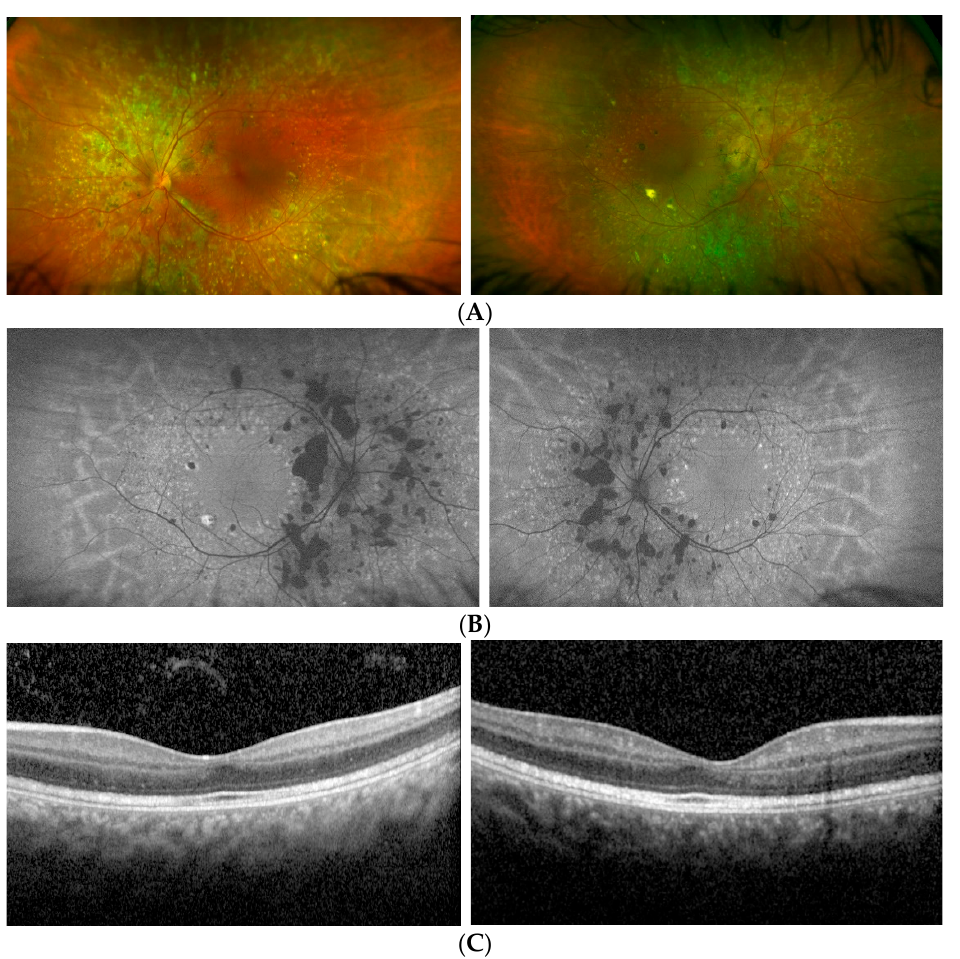
Figure 2. Retinal features of Patient 2: ( A ) Fundus of the right and left eye showing areas of chorioretinal atrophy with yellowish dots and retinal pigment epithelium mottling along the vascular arcades and relatively preserved macular area; ( B ) FAF images showing hypoautofluorescent patches corresponding to the atrophic lesions along the arcades and hyperautofluorescent spots corresponding to the yellowish dots; ( C ) HD SD-OCT macular B-scans showing normal foveal morphology with intraretinal lacunae mainly in the ONL, bordering to the ELM, associated with smaller lacunae in the INL and focal hyper-reflectivity in the GCL. The ELM, the myoid zone, the EZ, and the outer segment photoreceptor layers are not fragmented, but present multiple areas of slightly irregular optical density, mainly in the extrafoveal area.